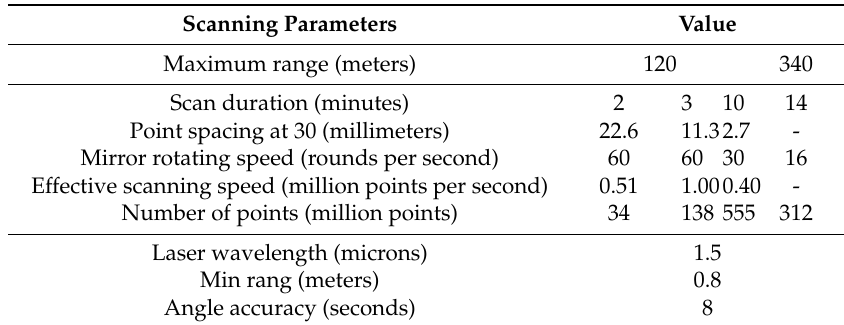
Table 2. Performance index of the Trimble TX8 terrestrial laser scanning (TLS). Note the value means the numeric value that each scanning parameters can